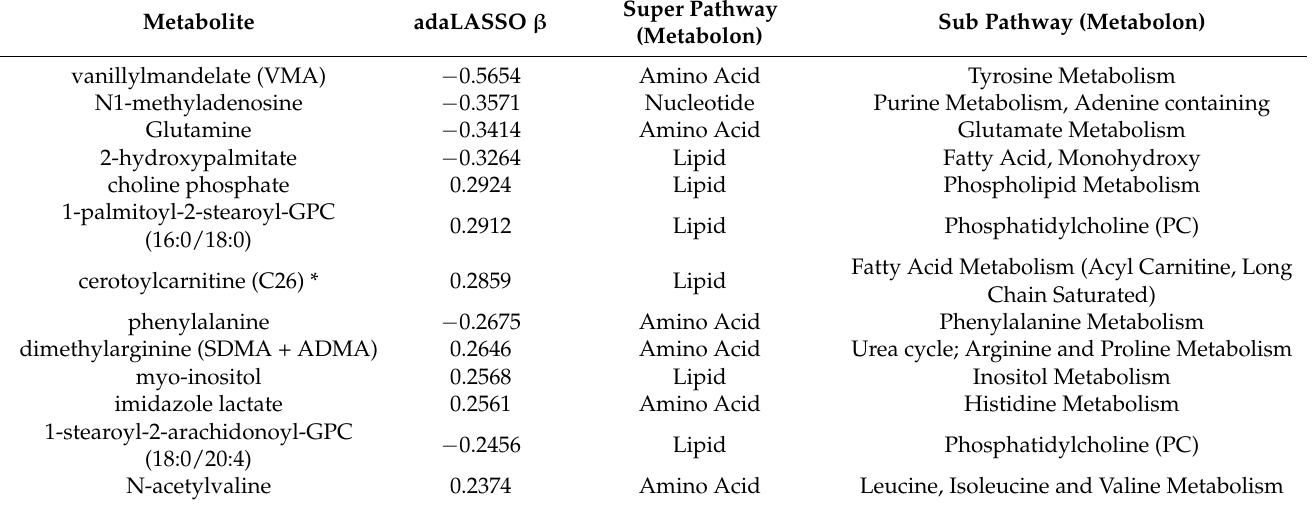
Table 2. Top 25 metabolites for FEV 1 from adaLASSO analysis, adaLASSO coefficient, and Super and Sub pathways annotated from